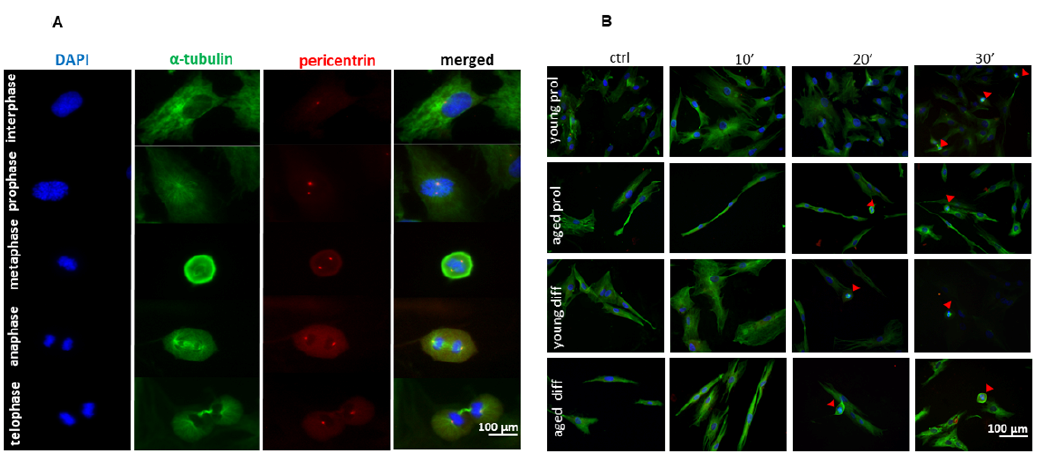
Figure 6. Distribution of mitotic phases in young and aged SCs/myoblasts after ViSS treatment. ( A ) Each mitotic phase was determined through visual identification of specific morphological features identified with DAPI, α -tubulin, and pericentrin labeling. ( B ) Representative fields from both age groups. Mitotic cells are marked with red arrows.